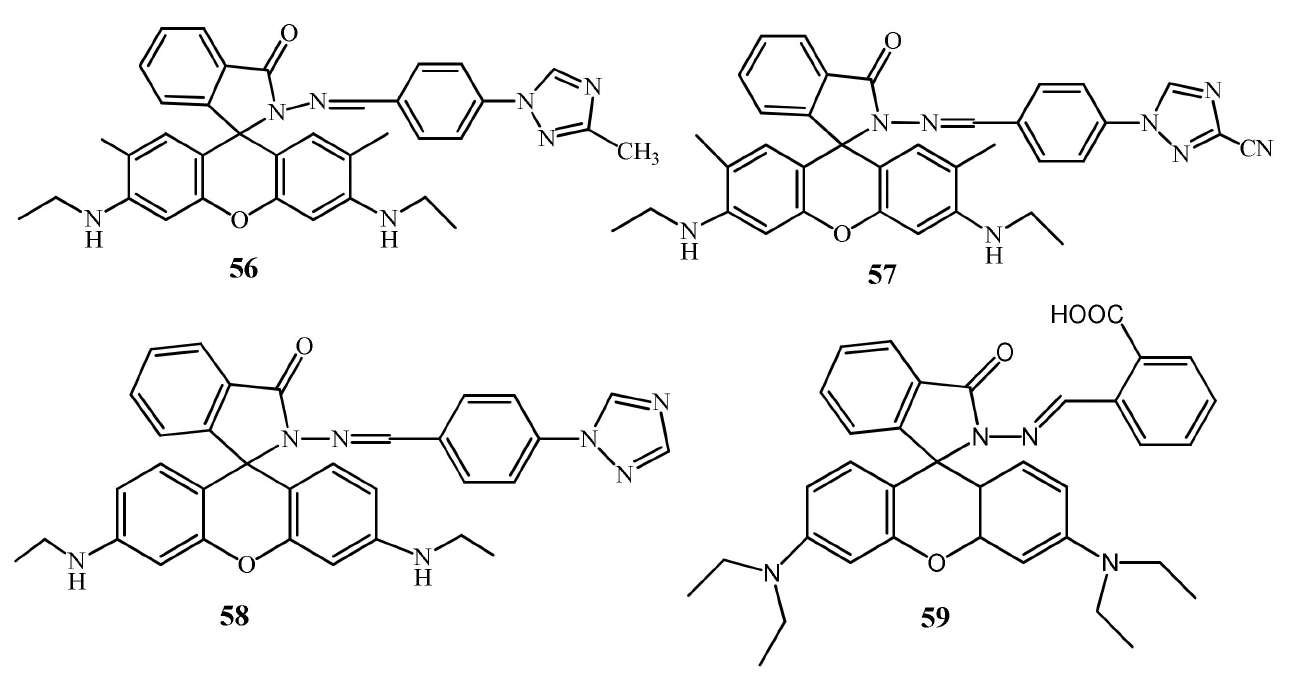
Figure 20. Molecular structures of the sensors 56 to 59